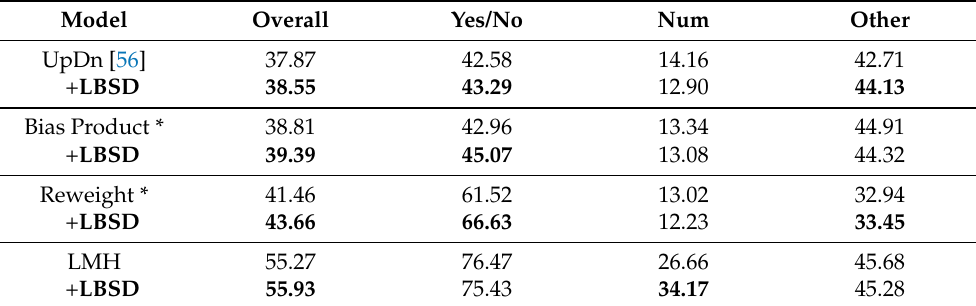
Table 3. VQA-CP v1: Ablation experiments of the LBSD method on the VQA-CP v1 dataset. * indi- cates the results from our reimplementation using officially released codes.